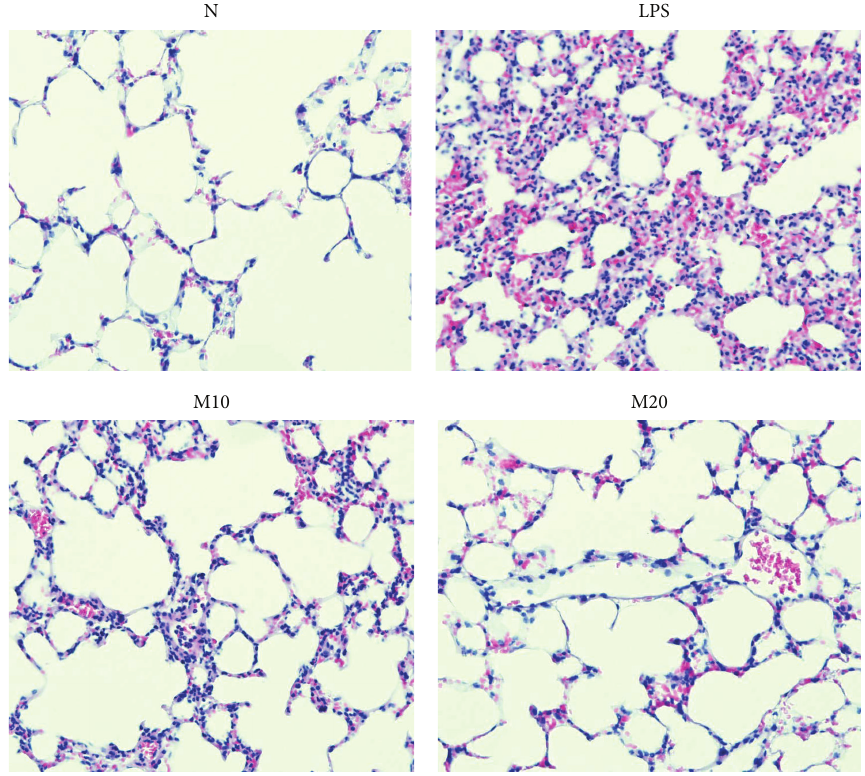
Figure 5: Matrine inhibits neutrophil infiltration. Hematoxylin and eosin staining was used for histological examination of airway inflammation in lung tissue (magnification, 400x). N group: normal control mice; LPS group: LPS treatment only; M10 group: 10 mg/kg matrine plus LPS; M20 group: 20 mg/kg matrine plus